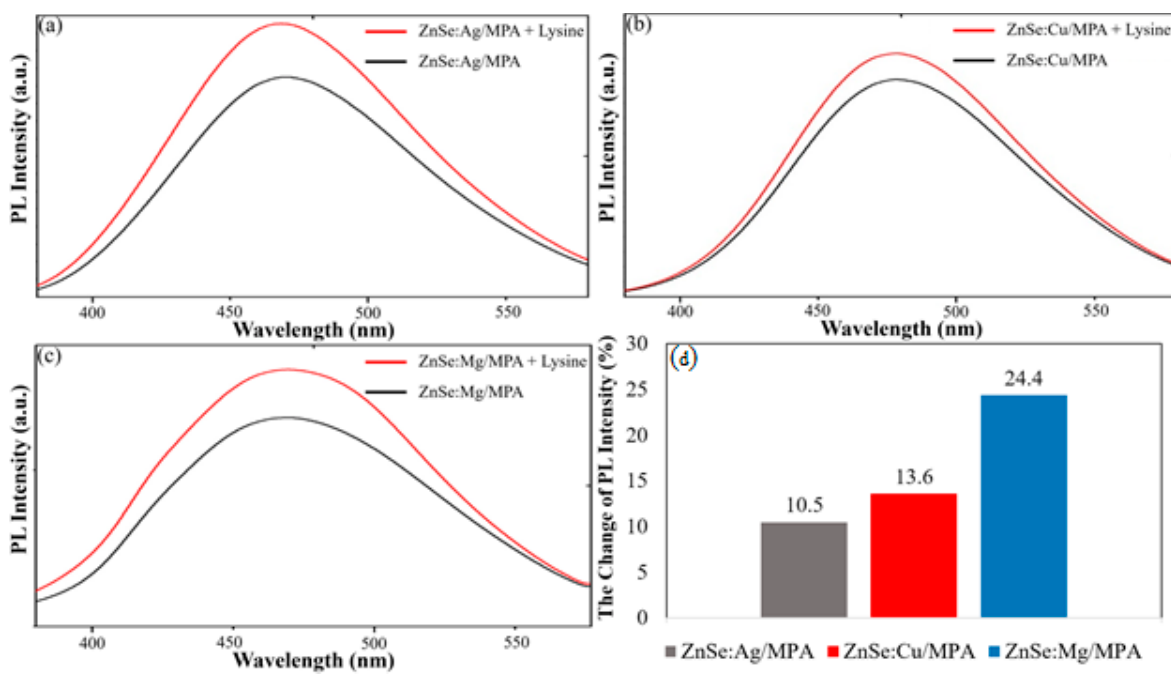
Figure 5. The PL intensity of ZnSe:X and ZnSe:X combined with lysine (0.3%): ( a ) ZnSe:Mg,